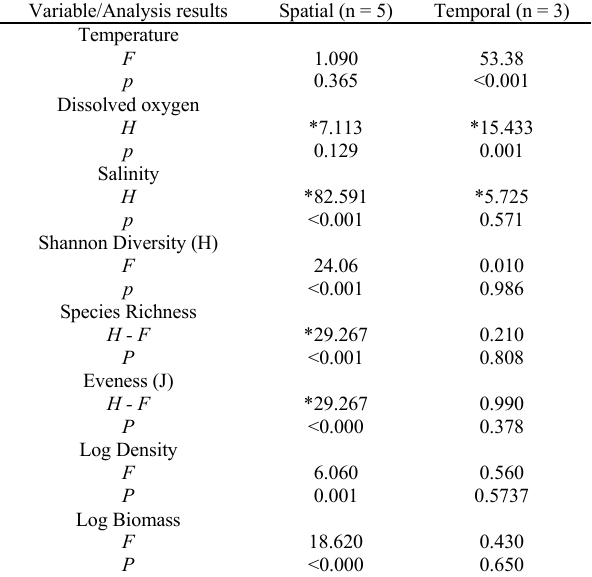
Table 2. Results of the ANOVA and Kruskal-Wallis* analyses to test for significant differences in environmental variables and for a number of ecological parameters of the fish community in Ría Lagartos Lagoon,